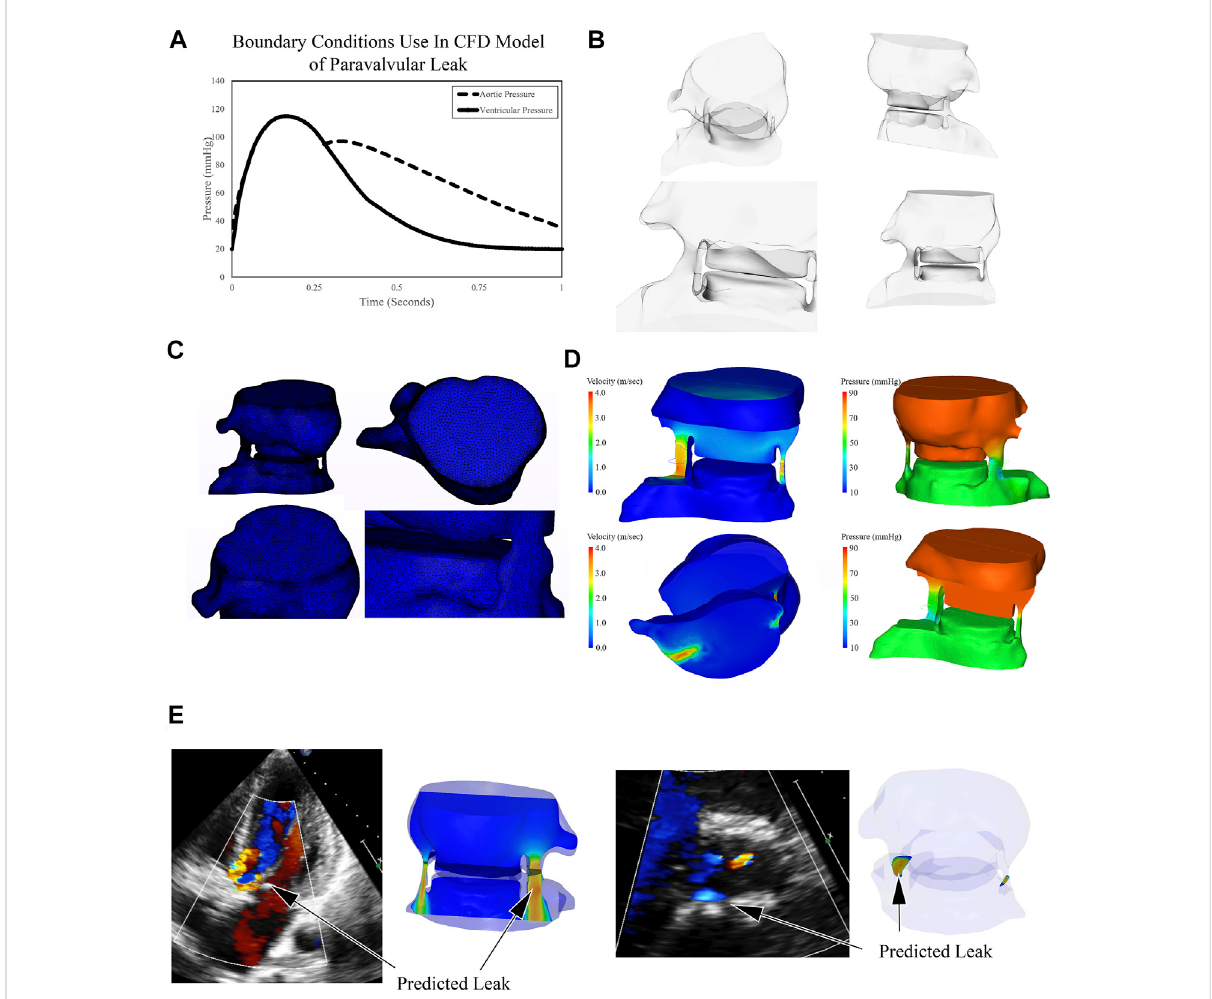
FIGURE 3 Outline of Computational Fluid Dynamics Strategy to Simulate and Quantify Paravalvular Leak. (A) Representative aortic blood pressure waveform was fi t to the patient ’ s post procedural blood pressure; ventricular waveform was estimated. These waveforms were used as boundary conditions for simulations. (B) Post procedural blood volume was generated in CAD software and converted to a 2.5 million element mesh (C) . CFD solver determined the pressure and velocity values for each element and blood fl ow during diastole was simulated, representative images are shown (D) .Paravalvularleakwaspredictedintwoareas,onelargeandonesmall.ThelargeareaofPVLwasseenonfollowupecho,asthesmallerwas likely obscured by the region of valvular insuf fi ciency (E)